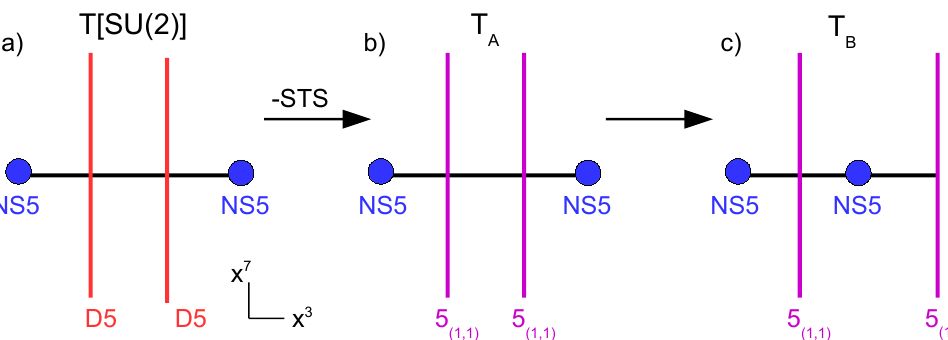
Figure 11 . The brane realization of T [SU(2)] (a) becomes the brane realization of T A (b) after an SL(2 ; Z ) transformation. Exchanging the right 5 e(cid:11)ect) leads to the brane realization of T B